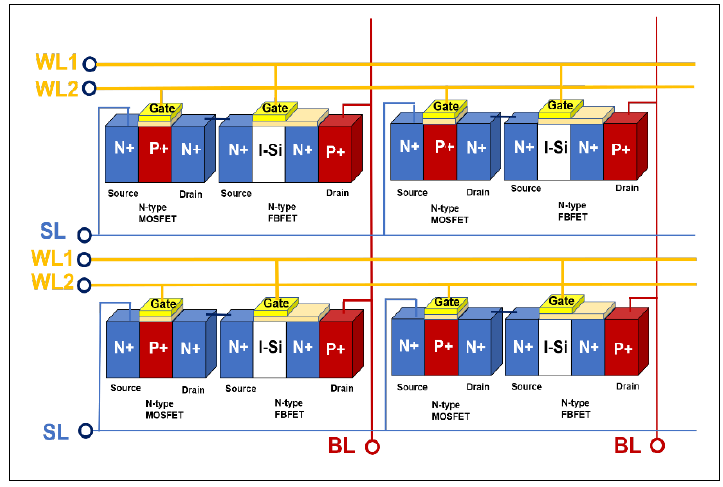
Figure 12. Illustrated 2T-static random-access memory (SRAM) circuit composed of FBFET [52].